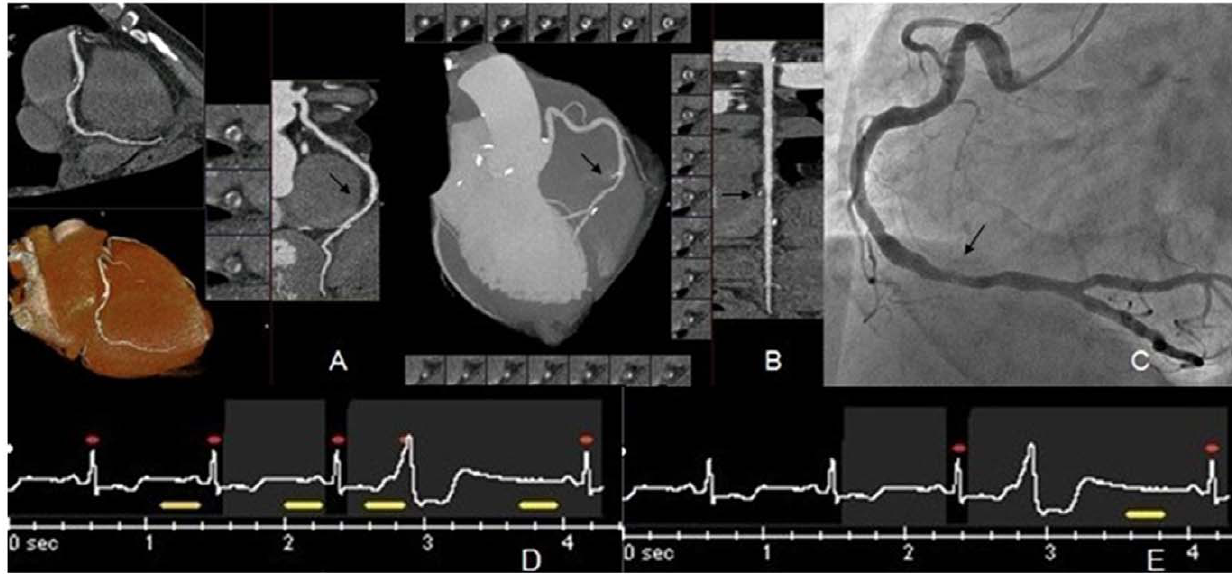
Figure 2. A male patient, 58-years-old, with an image quality score of 4. Figure A includes VR and CPR images, and Figure B includes an MIP image and a CPR straightened image used when measuring degree and range of luminal stenosis. The images show multiple soft plaques and calcified plaques at the right coronary and moderate stenosis at distal lumen (indicated by the superimposed arrow). Figure C is an example of coronary angiography, which demonstrates that it is in accordance with the results of CTCA. Figure D is an example of the ECG taken when data was acquired. Figure E show the ECG-edit later.